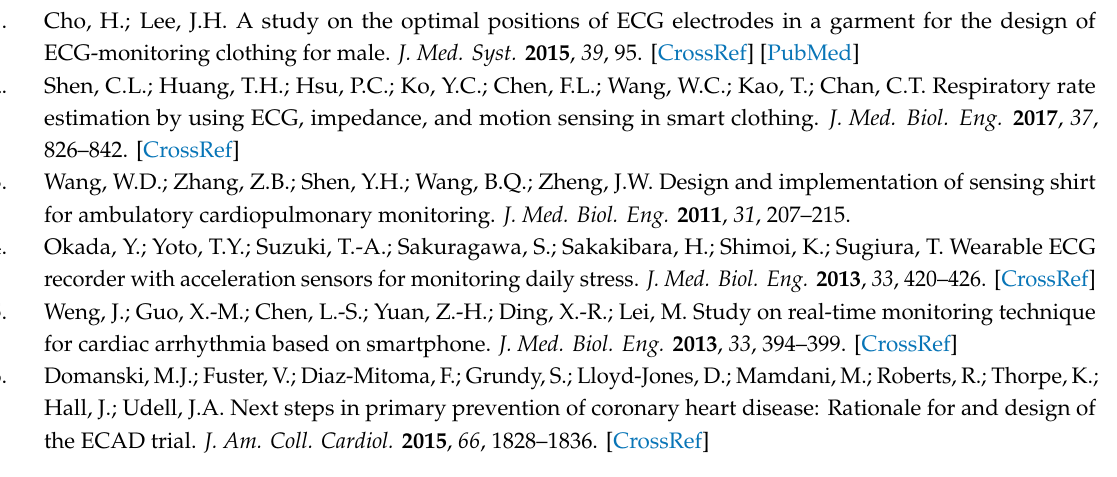
Figure S1: GPC curves for PIB-SA, POE-2000, and PIB-POE-PIB triblock copolymer. Figure S2: FT-IR spectra of PIB-SA, PIB-POE-PIB intermediate, and PIB-POE-PIB triblock copolymer. Figure S3: (a) PIB-POE-PIB triblock copolymer in di ff erent solvents: (1) DI Water, (2) DMF, (3) acetone, (4) ethanol, (5) THF, and (6) toluene. (b) Carbon black dispersed in (1) DI water, (2) DMF without PIB-POE-PIB, and (3) DMF with PIB-POE-PIB. Figure S4: (a) UV-vis absorption spectra. (b) TEM images of colloidal AgNP in DI water containing AgNO 3 and PIB-POE-PIB at weight ratios: (1) 1:1, (2) 5:1, and (3) 1:5. Figure S5: TGA plots of AgNPs / PIB-POE-PIB / carbon-based nanomaterials hybrids with di ff erent weight ratios. (a) AgNPs / PIB-POE-PIB / CB, (b) AgNPs / PIB-POE-PIB / CNT, and (c) AgNPs / PIB-POE-PIB / GO. Figure S6: Preparation of highly electrically conductive films. Photos of AgNP / PIB-POE-PIB / carbon-based nanomaterials hybrid films with a weight ratio of 20:20:1 heated at 80 ◦